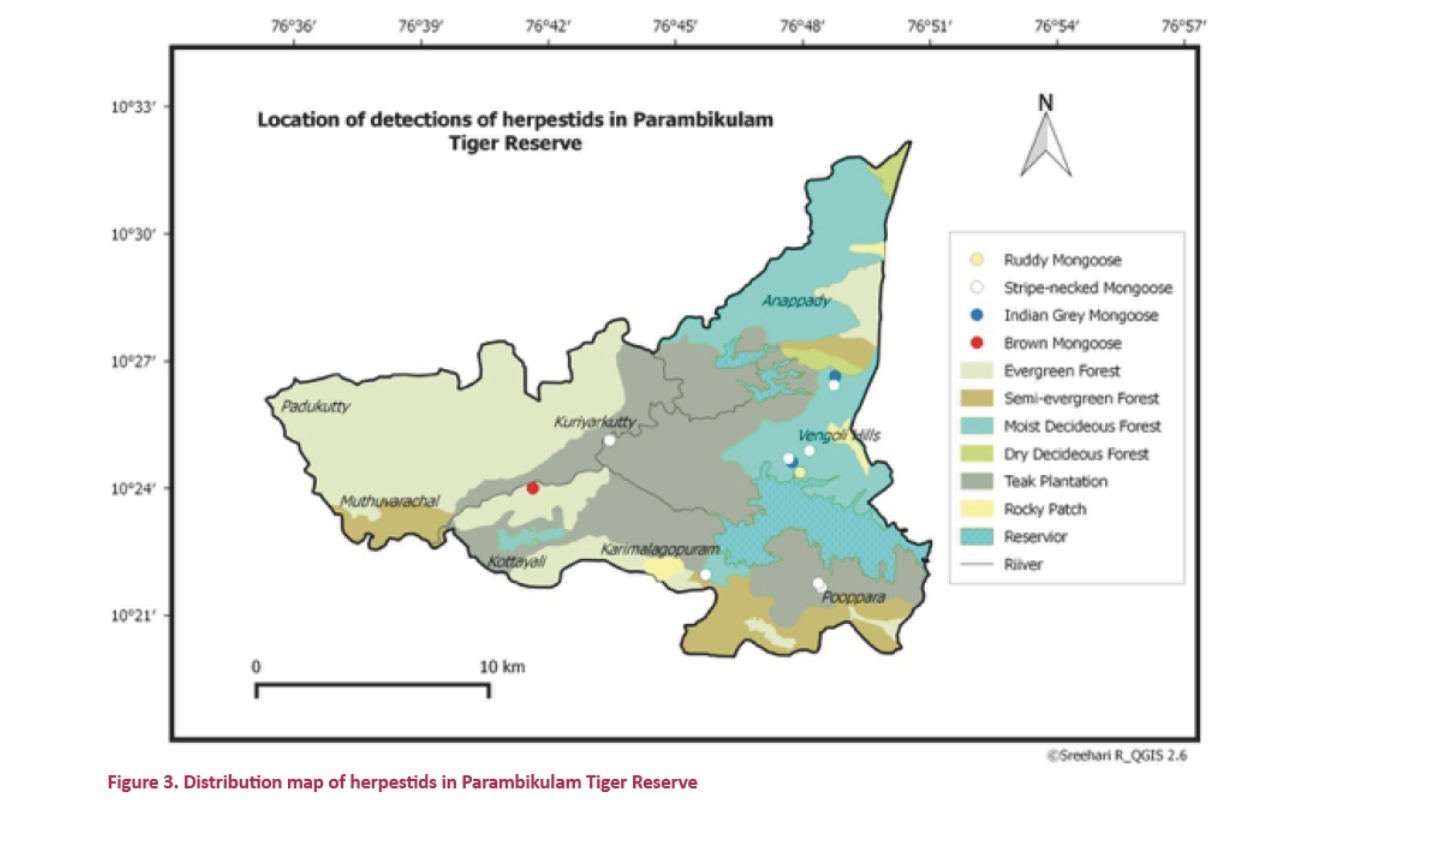
Ffigure 3. Dfistrfibufion map off herpesfids fin Parambfikulam Tfiger Reserve